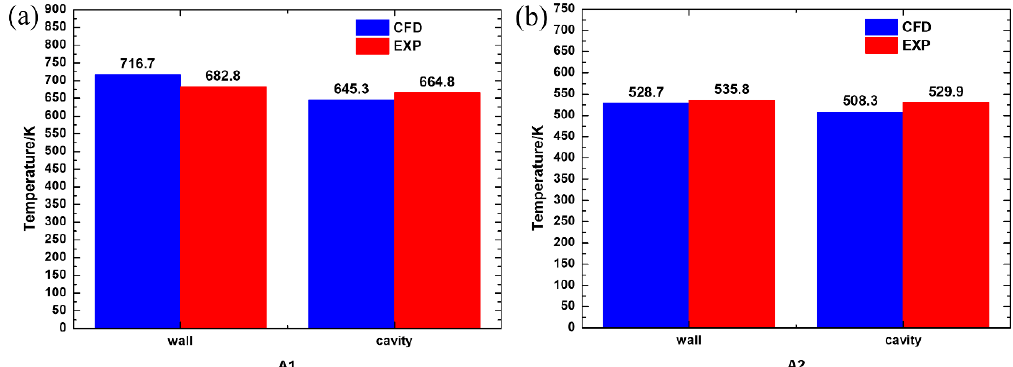
Figure 5. Comparison of the average temperature of the cavity and the casing wall obtained from the experiment and the simulation in Scheme 2: ( a ) section A1; ( b ) section A2.